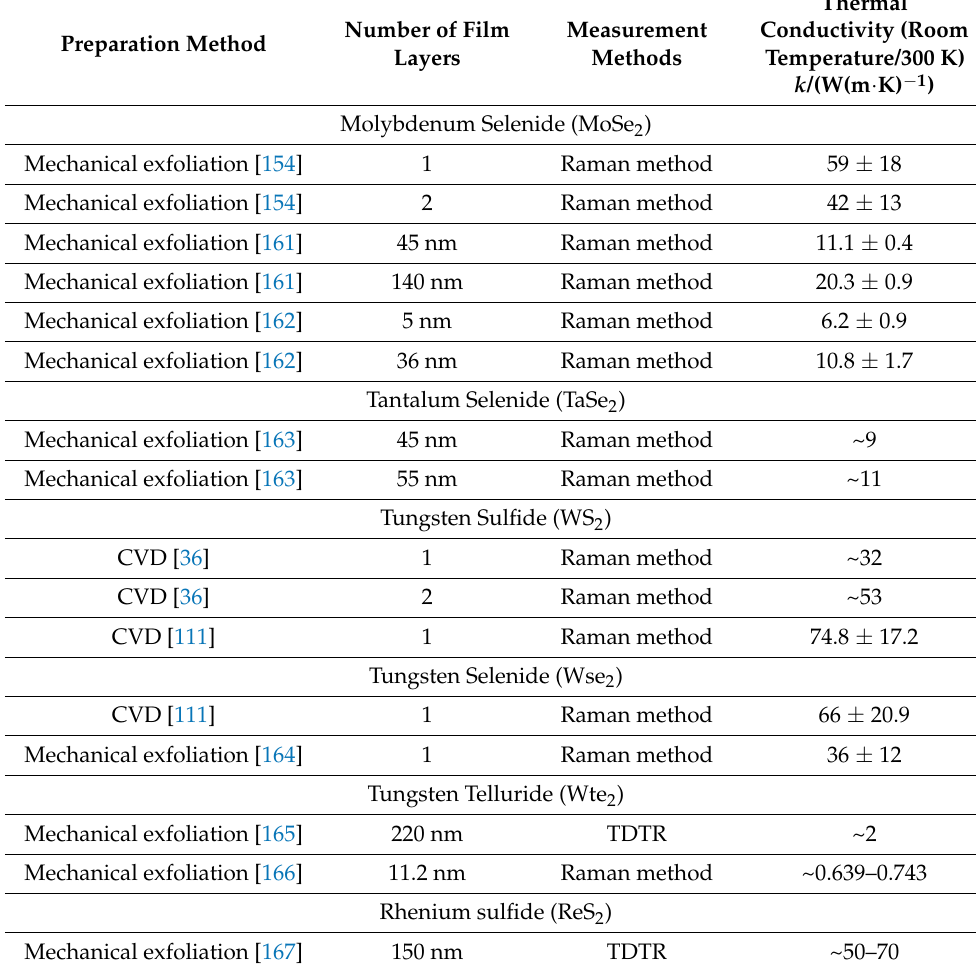
Table 4. Experimental detail of thermal conductivity of single-/few-layer transition metal dichalco- genides in different